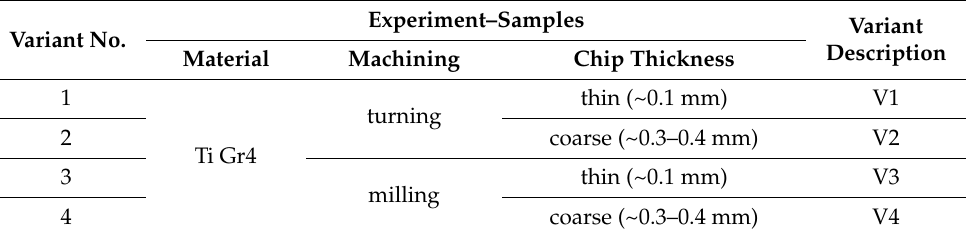
Figure 3. Sample views of the microstructures of the titanium Gr4 chips: ( a ) coarse chips obtained by turning—variant V2, ( b ) coarse chips obtained by milling—variant V4. 4.3. Briquettes Obtained after Preliminary Consolidation of Chips In this step, the chips thus obtained were subjected to a preliminary consolidation using the upsetting method. The compaction process was carried out in a vertical position using special tools and a conventional hydraulic press. The applied stamp load was in- creased up to 30 tons. Each process was conducted in multiple strokes. In this way, cylin- drical billets with a diameter of about 38 mm, called “briquettes”, were obtained. Each of the four types of chips was compacted separately, thus four individual briquettes were prepared. The briquettes were characterized by a porous macrostructure consisting of de- formed, tangled, bent and compacted chips. In this way, special, characteristic macro- structures consisting of chips were formed, where the chips had their own microstructure. For each type of chip, one separate briquette was obtained. Sample macroscopic views of the manufactured briquettes are presented in Figure 4a (variant V2) and Figure 4b (variant V4). As can be seen, the briquettes were solid and they formed the agglomerate, with rel- atively strong mechanical connections between particular macro-elements (chips).